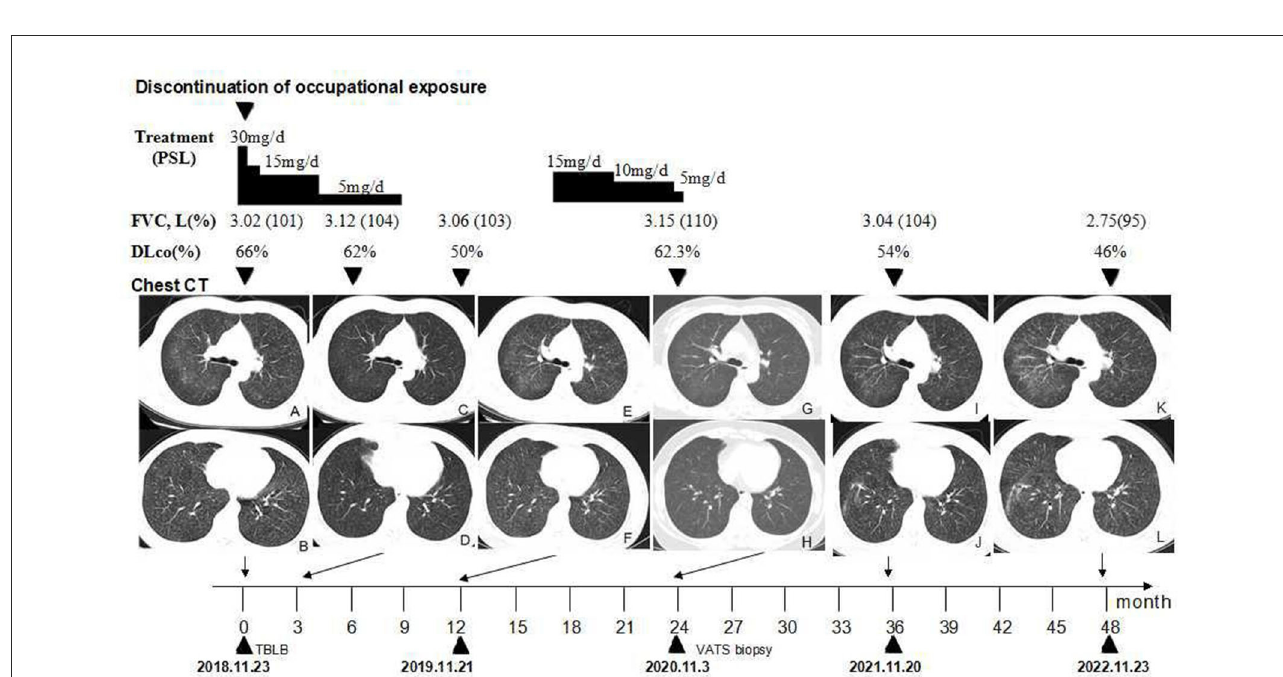
FIGURE2 Timeline of the clinical course. (A, B) Chest CT showing scattered GGOs on bilateral lobular areas of ground glass attenuation and centrilobular nodules throughout the lung parenchyma before treatment. (C, D) GGOs are significantly reduced after the cessation of occupational exposure and using oral prednisone for 3 months. (E, F) GGOs and centrilobular nodules recurred after the cessation of prednisone for 3 months. (G, H) GGOs and centrilobular nodules significantly reduced after the second course of using oral prednisone for approximately 28 weeks. (I–L) Follow-up after the cessation of occupational exposure for 3 years (I, J) and 4 years (K, L) , the number of ground glass nodules in her lungs is slightly increased when compared, and fiber streak shadows are observed in the lower lobe of her right lung. CT, high-resolution computed tomography; GGOs, ground-glass opacities; PSL,